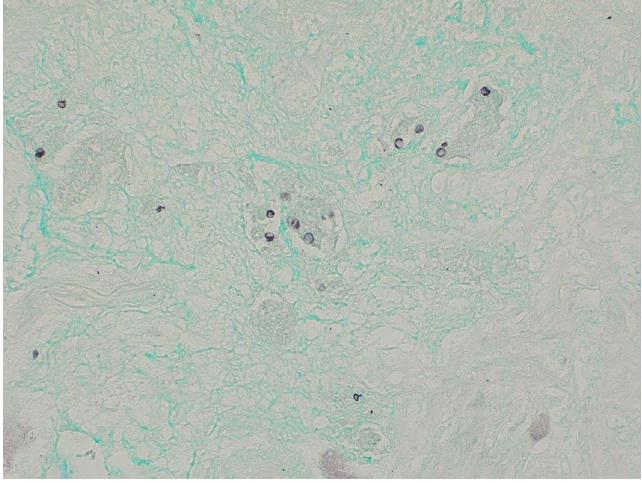
Figure 5: Gomori methenamine silver stain showing organisms compatible with Pneumocystis jirovecii